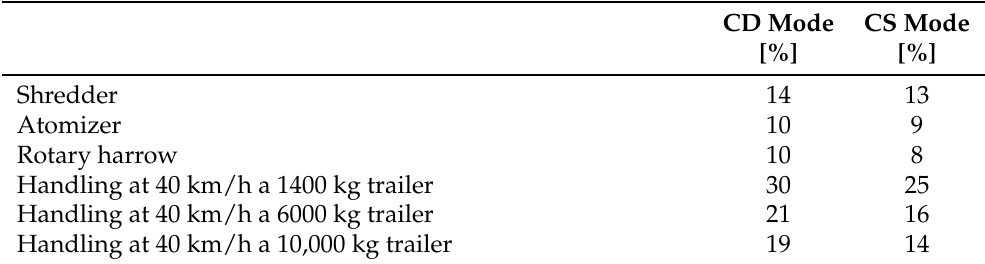
Table 7. Equivalent energy saving of the HeCVT architecture in CD and CS modes compared to the reference values of the conventional powertrain for the same tasks.